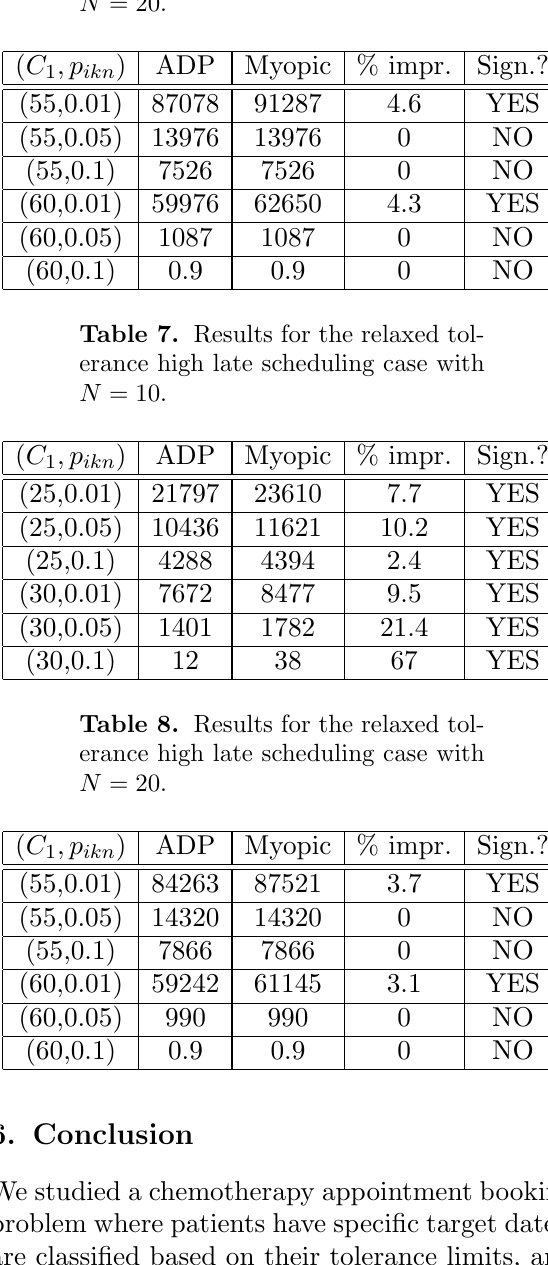
Table 6. Results for the relaxed tol- erance high early scheduling case with N = 20.